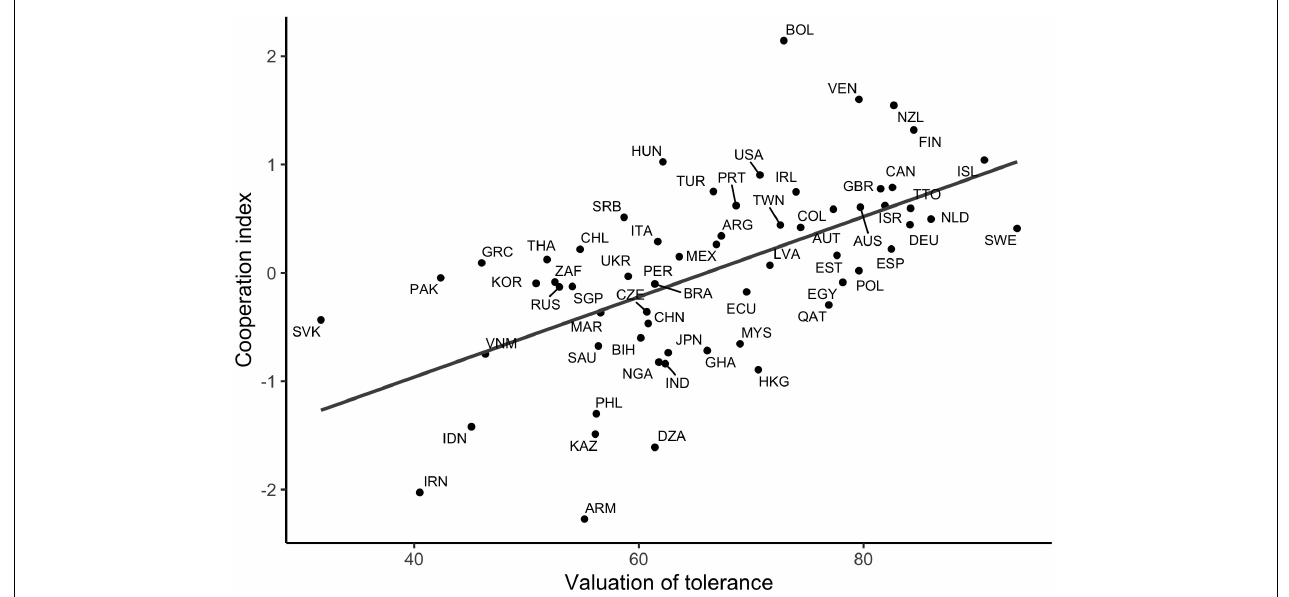
FIGURE 1 | Scatter plot of the cooperation index against the valuation of tolerance in 62 societies, abbreviated according to the ISO three-letter standard. The plot shows that the cooperation index (a composite measure of cooperative behavior, norms, and metanorms) is higher in societies where tolerance is a more highly valued quality in persons; the regression line explains 34% of the